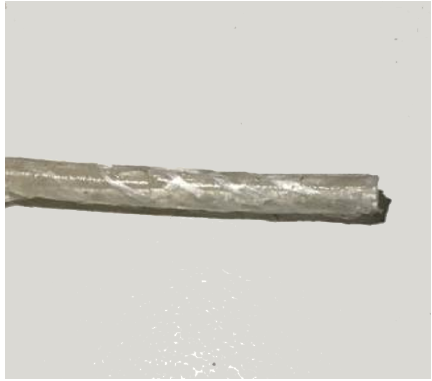
Figure 9. Real photo of the resulting